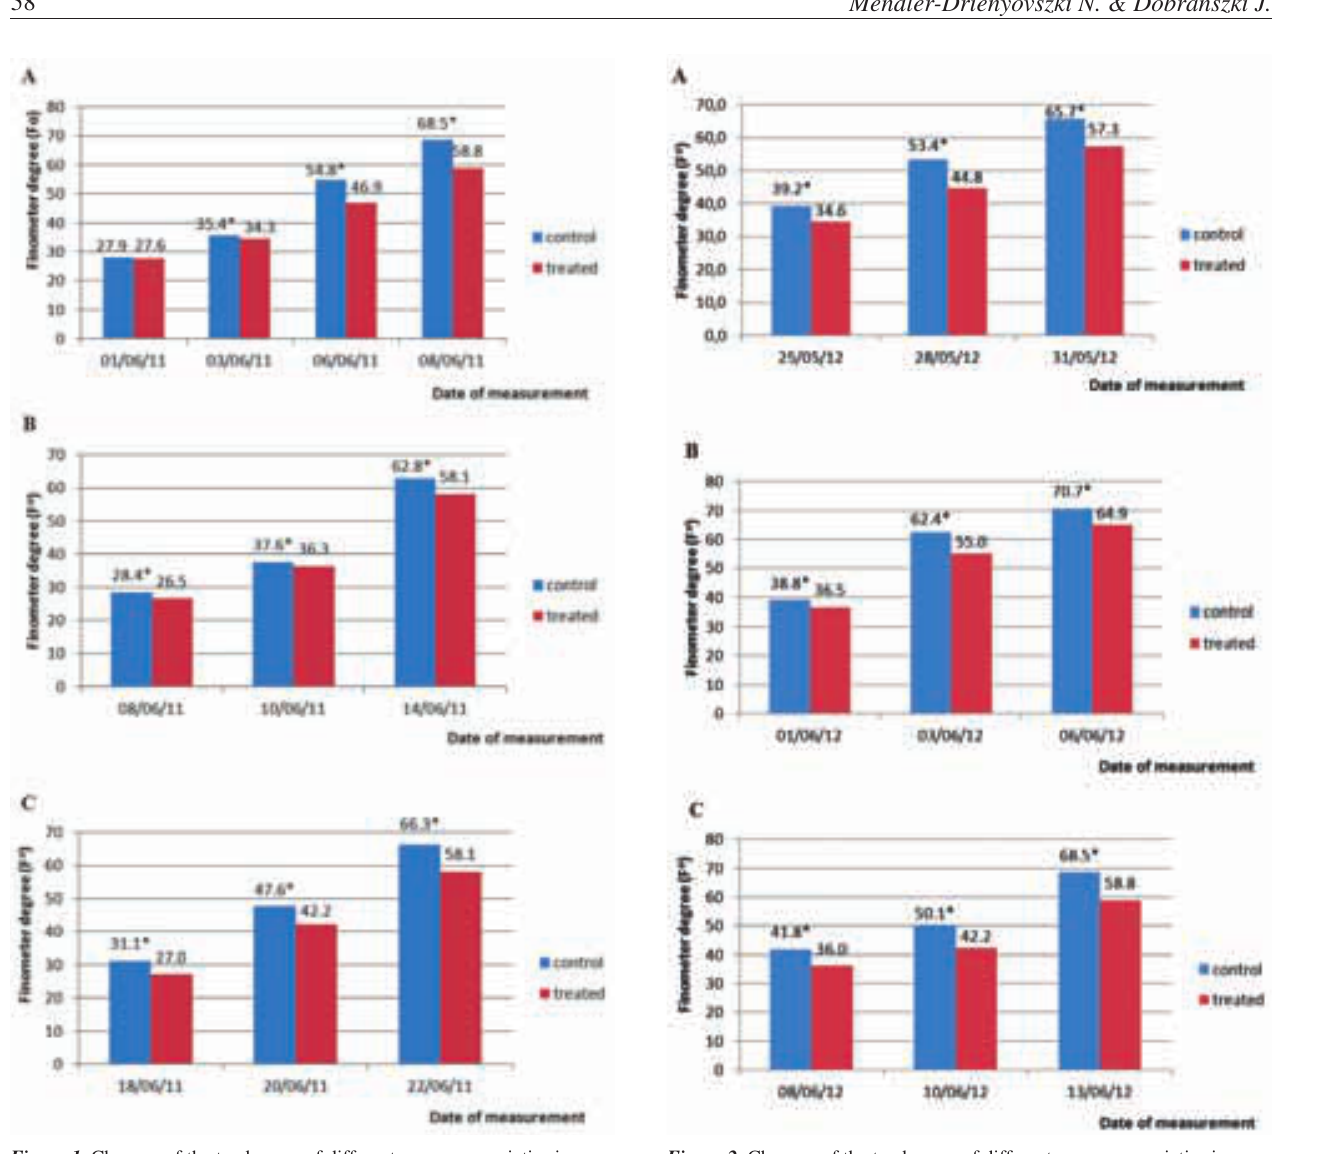
Figure 2. Changes of the tenderness of different green pea varieties in 2012. A: ‘Léda’ B: ‘Zita’ C: ‘Zsuzsi’. * signifi cant differences (P<0.05);